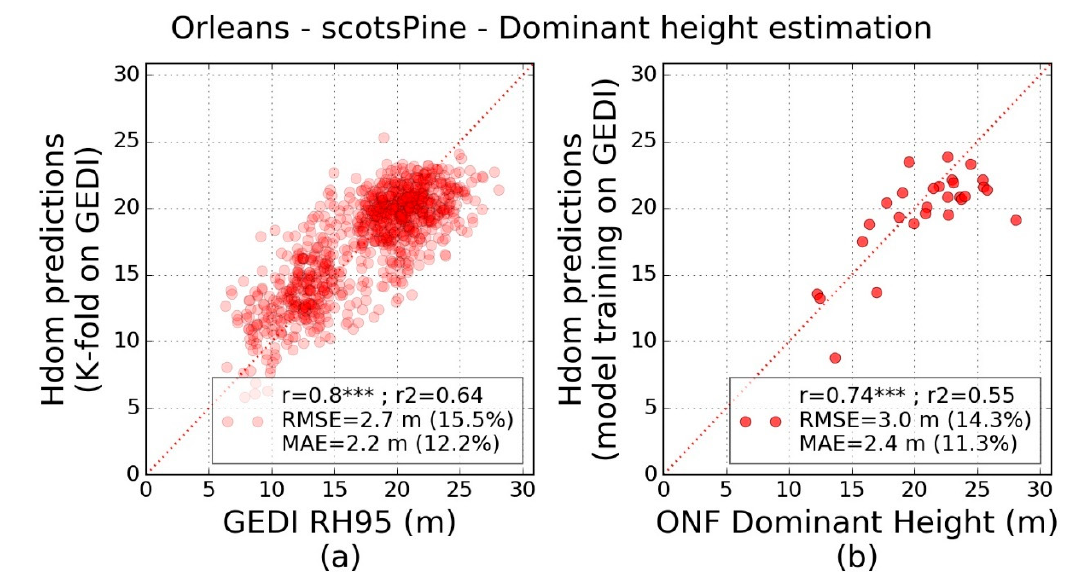
Figure 9. Scots pine samples (Orléans). Validation scatterplots of dominant height estimation using GEDI RH95% metric for the training model (958 samples). ( a ) GEDI’s K-fold cross-validation; ( b ) application of GEDI model on ONF measurement plots (28 samples). Statistical signicicance: *** p ≤ 0.001.